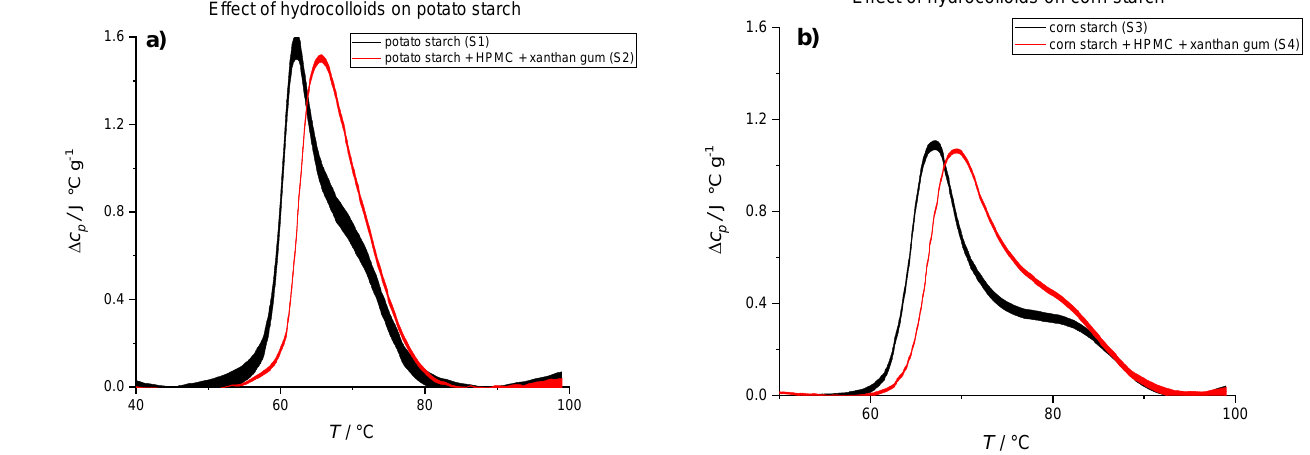
Figure 4. DSC thermograms showing effects of hydrocolloids on the gelatinization behavior of starches. ( a ) Thermally induced transition of 50% potato starch suspension in water (black line, S1) and thermally induced transition of 38% potato starch, 8% HPMC, and 4% xanthan gum suspension in water (red line, S2). ( b ) Thermally induced transition of 50% corn starch suspension in water (black line, S3) and thermally induced transition of 38% corn starch, HC mixture (8% HPMC and 4% xanthan gum) dissolved in water (red line, S4). The lines represent averages of three independent experiments ( n = 3) and the line thickness corresponds to SD. All concentrations are given as ( w / w ). Table 4. Thermodynamic profile ( Δ H transition and T transition ) of thermally induced transitions of starch suspensions without/with HC mixture (8% HPMC and 4% xanthan gum).